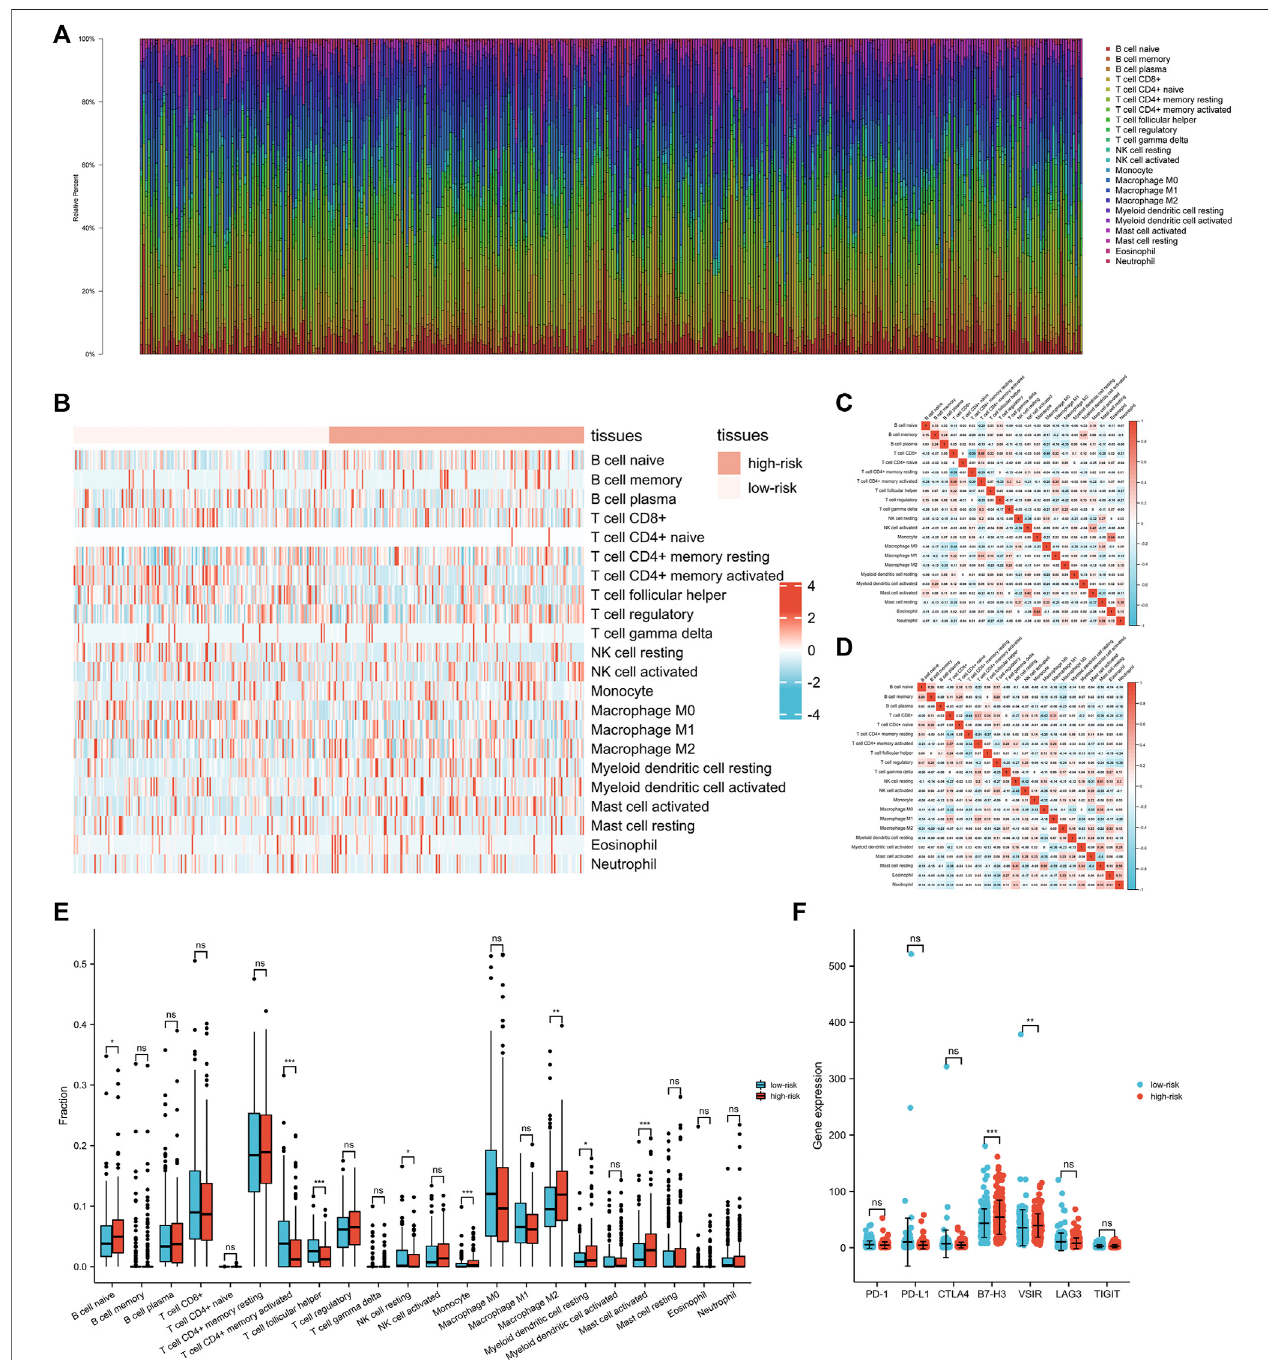
FIGURE 6 | The interactions between exosomes-related lncRNA signature and immune regulation in gastric cancer (GC) patients. (A) The barplot of the tumor- in fi ltrating cell proportions. (B) The heatmap of the tumor-in fi ltrating cell proportions. (C) Correlation matrix of immune cell proportions in the low-risk group. (D) Correlationmatrixofimmunecellproportionsinthehigh-riskgroup. (E) Comparisonsofimmunecellproportionsbetweenthelow-riskgroupandthehigh-riskgroup. (F) Comparisons of multiple immune checkpoints between the low-risk group and the high-risk group, including PD-1, PD-L1, CTLA4, B7-H3, VSIR, LAG3, TIGIT.